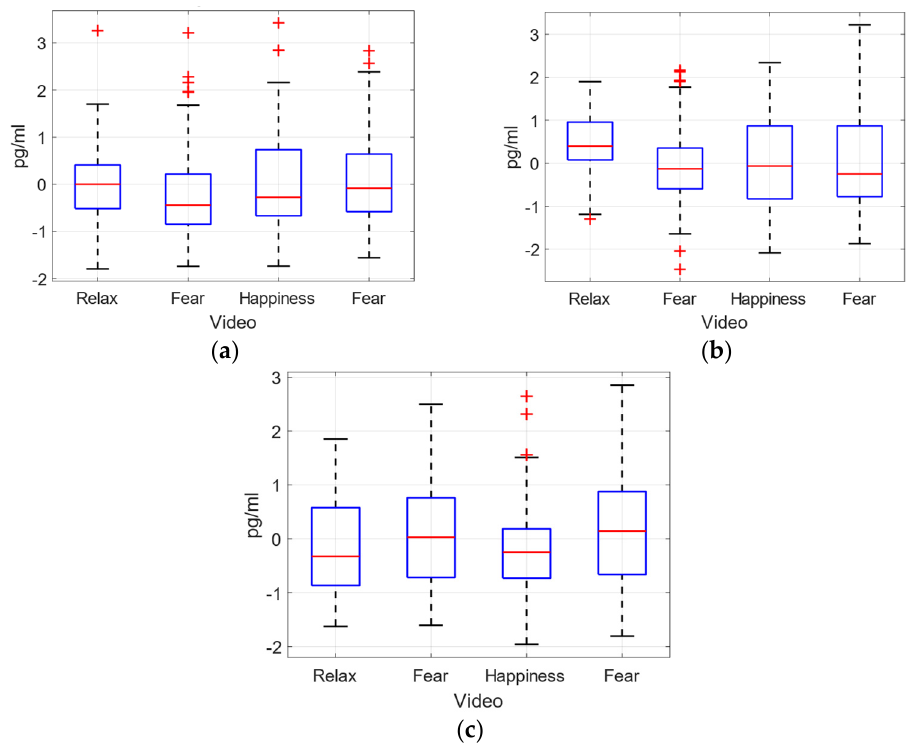
Figure 14. Normalized concentrations for dopamine, adrenaline and nor-adrenaline ( a – c ) for every video clip.